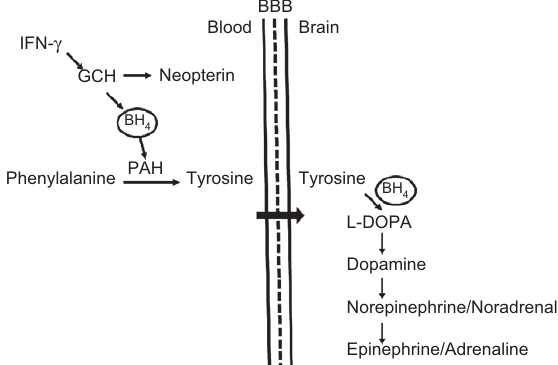
Figure 1 The proinflammatory cytokine IFN- γ is preferentially released during the process of Th1-type immune activation. The cytokine induces the expression of enzyme GCH, which, in most human cells and cells from other species, results in the forma- tion of cofactor BH . Only human and primate monocyte-derived 4 macrophages and dendritic cells produce neopterin instead of BH . In the liver and kidneys, the enzyme PAH converts Phe to Tyr, 4 requiring BH as a cofactor. Tyr deficiency may cause an insufficient 4 production of biogenic amine neurotransmitters noradrenaline (norepinephrine) and adrenaline (epinephrine), which can underlie the development of mood changes and fatigue in patients with inflammatory